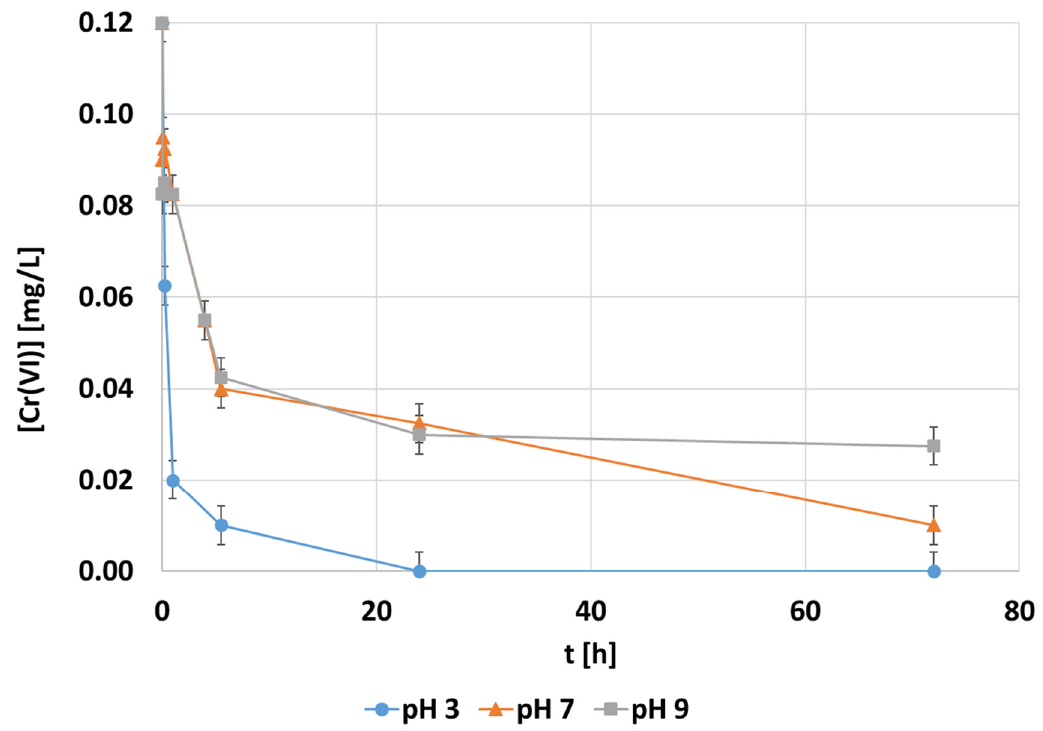
Figure 4. The evolution of the hexavalent chromium concentration [mg · L − 1 ] during adsorption with the CNF hydrogel at 0.1 mg · L − 1 of the initial chromium concentration, 1.5 mmol MTMS · g − 1 CNF applied during hydrophobization, and 1000 mg CNF·L − 1 of dosage under different pH conditions. The obtained adsorption capacity data were evaluated through different kinetic mod- els. The result of plotting each fitted kinetic to the pH 3 experimental data can be observed